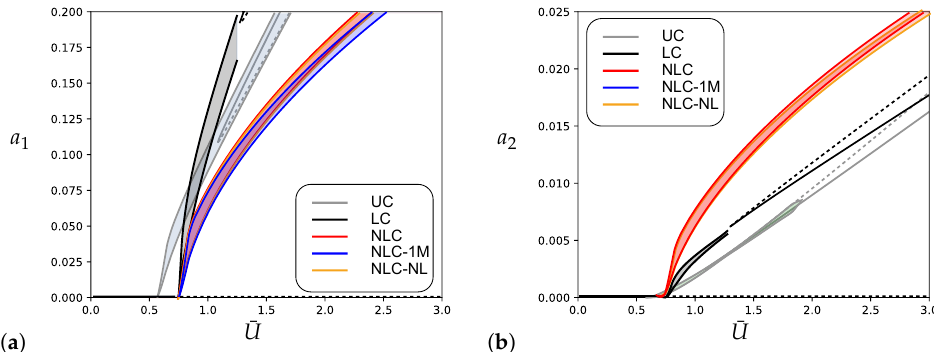
Figure 8. Bifurcation diagram for σ e = 0.003, σ i = 0: ( a ) amplitude a 1 ; ( b ) amplitude a 2 (solid line: stable; dashed line: